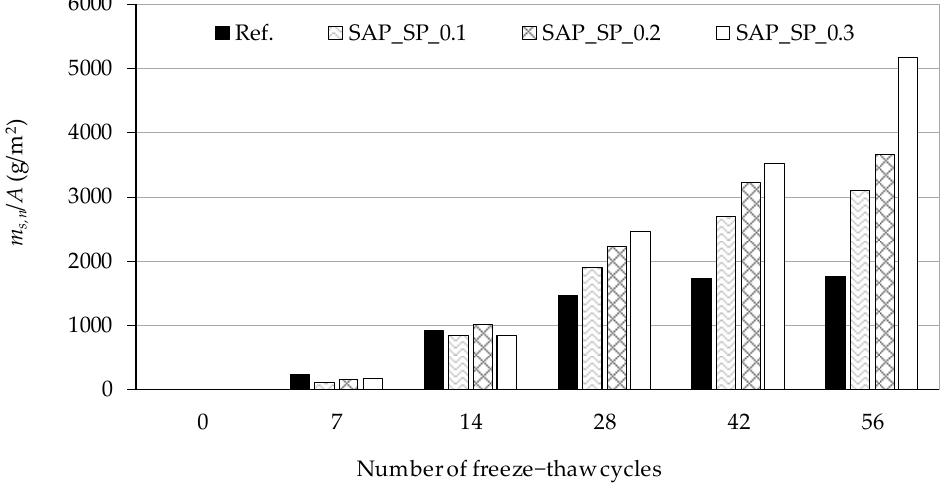
Figure 8. Cumulative mass of fragments scaled from unit area of sample surface ( m s,n /A ) according to the number of freeze–thaw cycles .